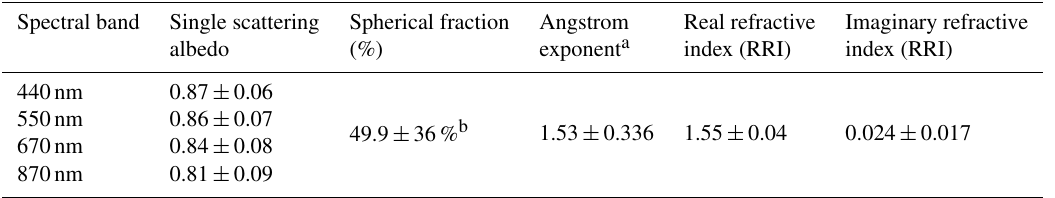
Table 6. Mean aerosol optical and microphysical properties retrieved for the smoke scene in Fig. 9 (for pixels with AOD 440nm > 0 . 4). Spectral band Single scattering Spherical fraction Angstrom Real refractive Imaginary refractive albedo (%) exponent a